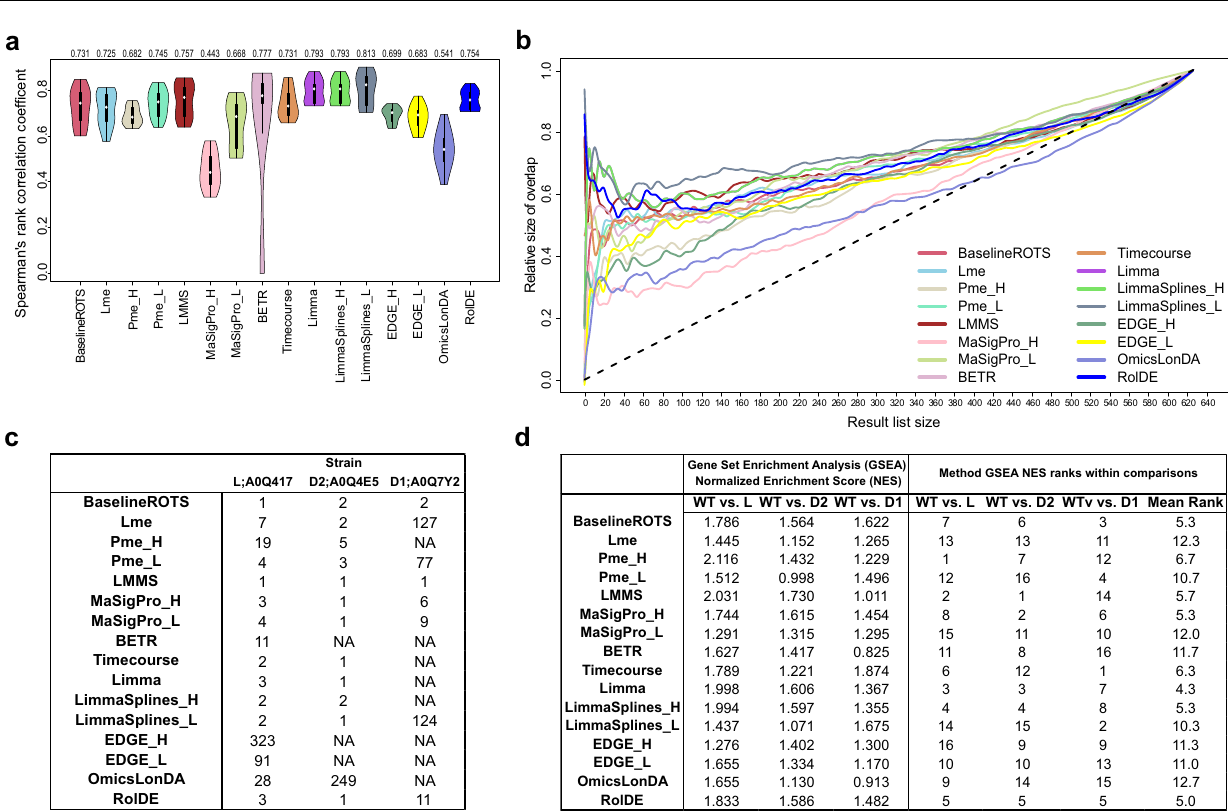
in a and b . c Rankingsoftheproteinsrelatedtothemodi fi edacyltransferaseswhen longitudinaldifferentialexpressionwasexaminedbyeachmethodineachpairwise comparison between the null mutant strains LpxD1 (D1), LpxD2 (D2), LpxL (L) and the wild type (WT) over the fi ve temperatures. The UniProt accession of each proteinrelatedtothemodi fi ednullmutantisshown.NAreferstonotdetectedatall by the method. d The normalized enrichment scores (NES) from the gene set enrichment analysis (GSEA) of the relevant Lipopolysaccharide synthesis pathway and the associated knockoutpathwayproteins among the fi ndings of the different methods in comparisons of the acyltransferase null mutant strains and the wild type. The NES scores of the methods were ranked within each comparison and a mean rank was calculated over all the comparisons for each method. Source data are provided as a Source Data fi